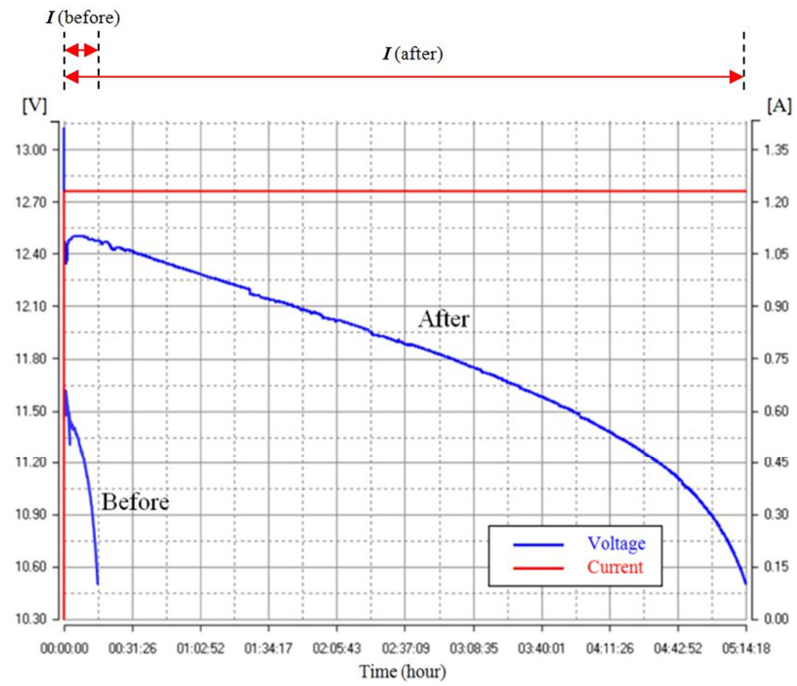
Figure 9. Five-hour discharge curves of one of the recovered batteries.